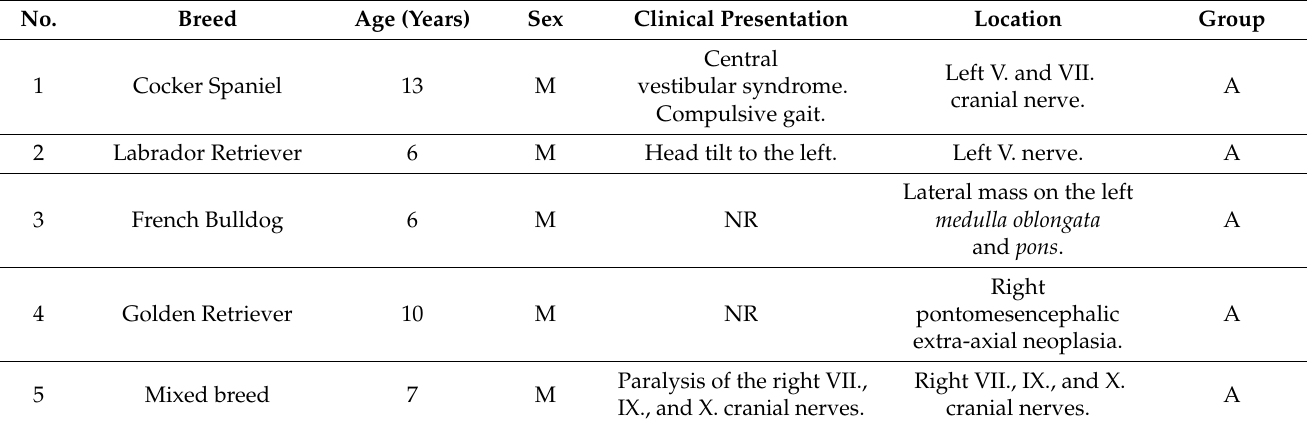
Table 3. Signalment, clinical features, and tumor localization of the dogs included in the